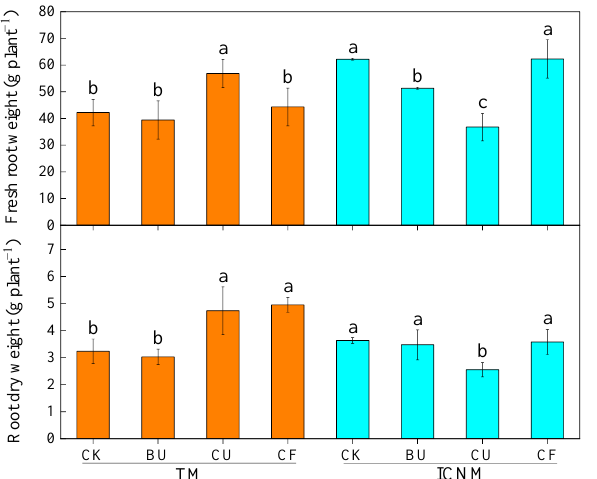
Figure 4. Dry and fresh root weight of different treatments. Different lowercase letters indicate significant differences at p = 0.05, the same below.